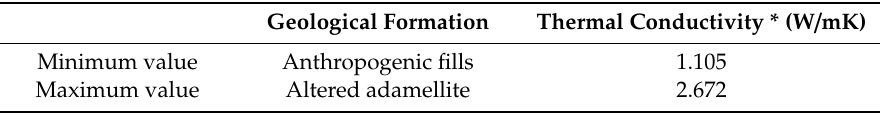
Table 3. Highest and lowest thermal conductivity values detected for the formations constituting the borehole under study.